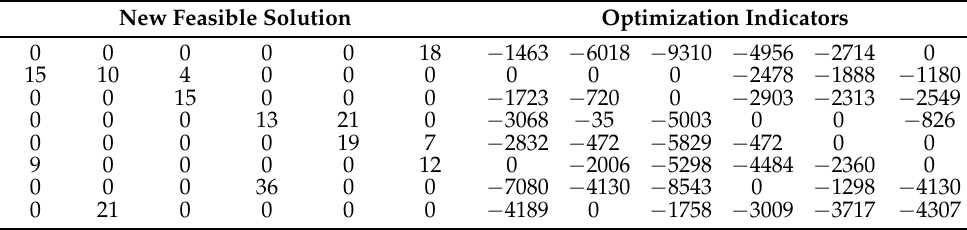
Table 13. New solution and optimization indicators.